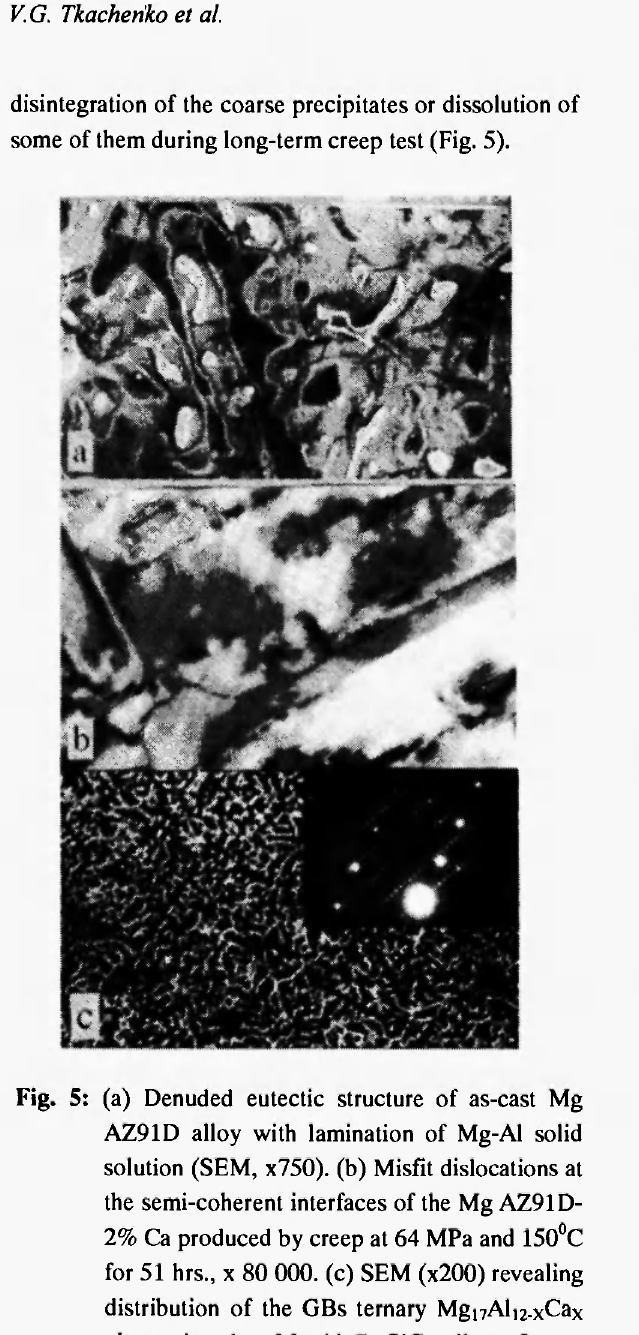
Fig. 5: (a) Denuded eutectic structure of as-cast Mg AZ91D alloy with lamination of Mg-Al solid solution (SEM, x750). (b) Misfit dislocations at the semi-coherent interfaces of the Mg AZ91D- 2% Ca produced by creep at 64 MPa and 150°C for 51 hrs., χ 80 000. (c) SEM (x200) revealing distribution of the GBs ternary Mgi 7 Al 12 .xCax phase in the Mg-Al-Ca-SiC alloy. selected area electron diffraction pattern